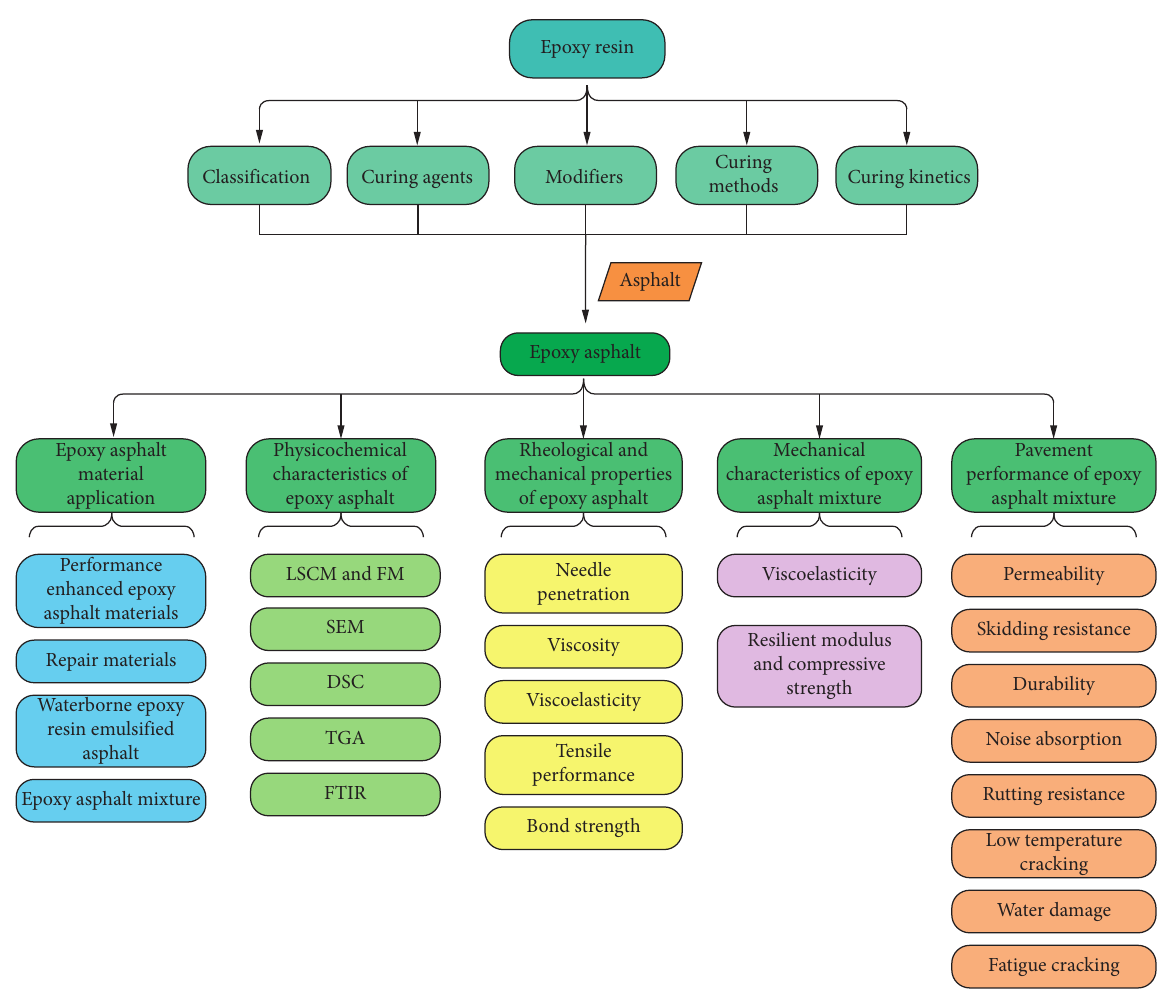
Figure 1: The flow chart of this review